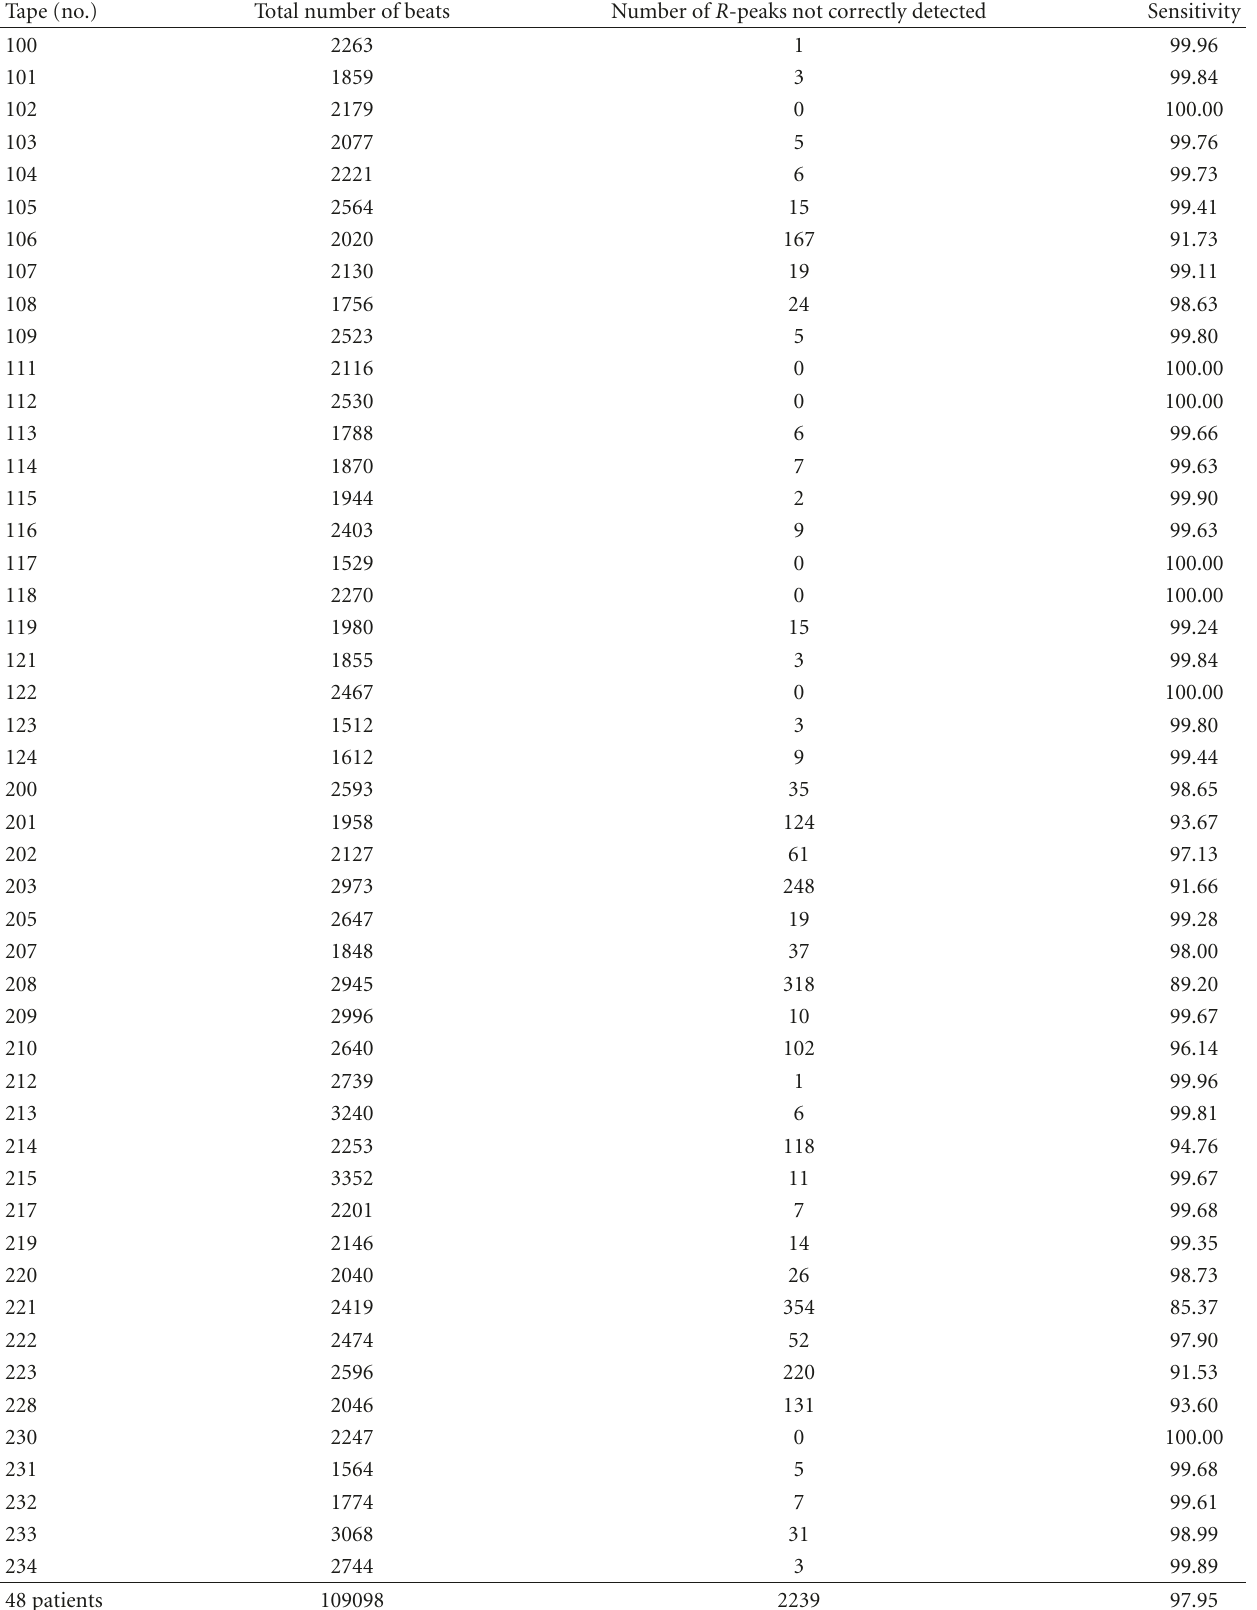
Table 1: Results of evaluting the ECG R -peaks detection algorithm using the MIT/BIH